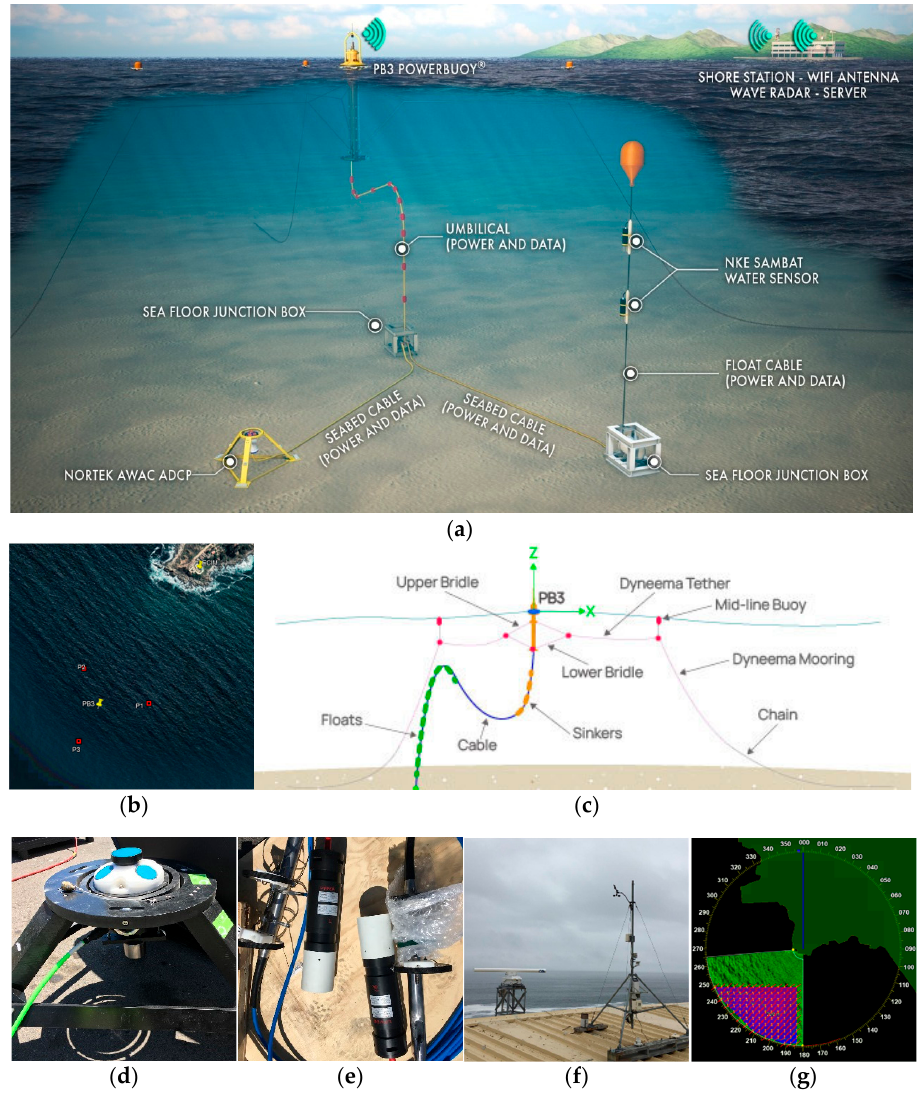
Figure 5. ( a ) General arrangement of the OSL project, including the PowerBuoy and sensors and their layout with respect to ECIM. ( b ) Array of mooring lines, where “P” is the anchor’s final location. ( c ) Diagram of mooring lines of the OSL and specific components of the system. ( d ) ADCP AWAC 600 kHz from Nortek installed on the self-aligning structure. ( e ) Image of the two water- quality sensors before sea deployment. ( f ) Atmos meteorological station and X-band radar on the roof of ECIM. ( g ) Image of the measurements and detection area of the X-band radar with a range of 1.5 km.